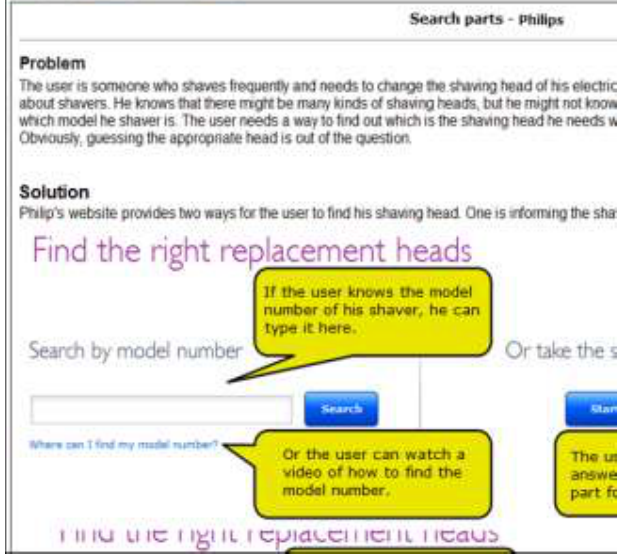
Fig. 3. Case description (problem and solution), cropped.